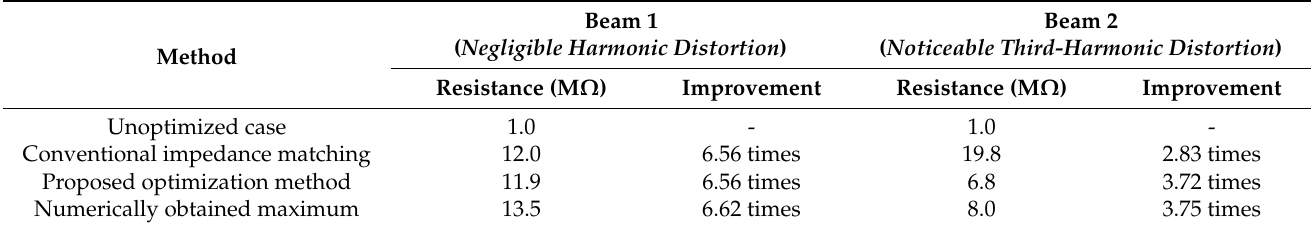
Table 2. Summary of the values of the external load resistance and relative improvements in broadband performance.